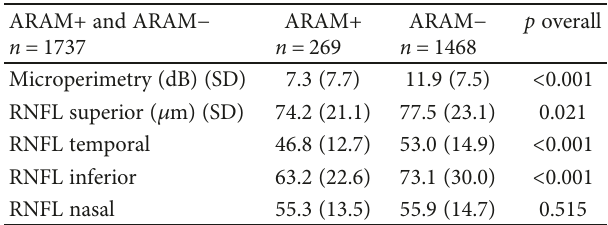
Table 4: Microperimetry and peripapillary OCT RNFL of superior, inferior, temporal, and nasal quadrants of ARAM+ were compared with those of ARAM − .